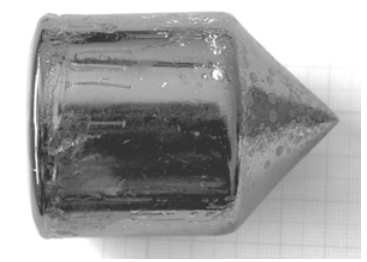
Figure 11. 2-inch as-grown CdZnTe